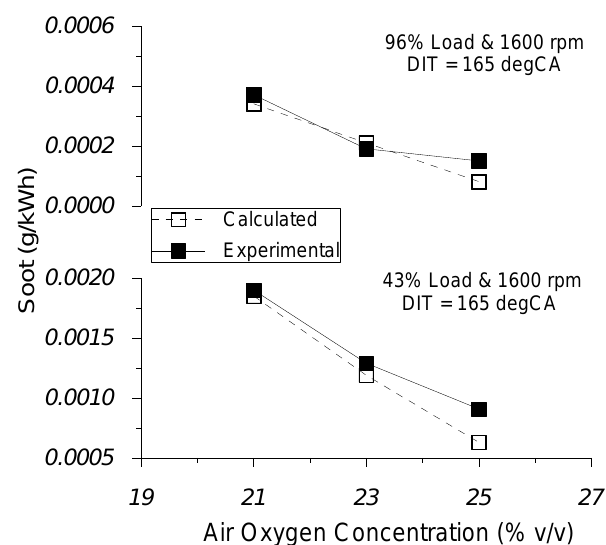
Figure 5. Comparison between experimental and computed specific CO concentration as a function of “inlet-air oxygen ratio”, for N = 1600 rpm and “a” = 20%, at 43% and 96% of engine rated load.